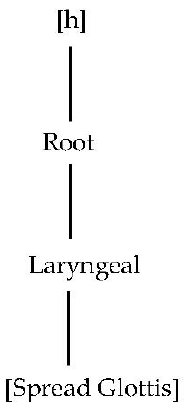
Figure 12. Feature geometry of English